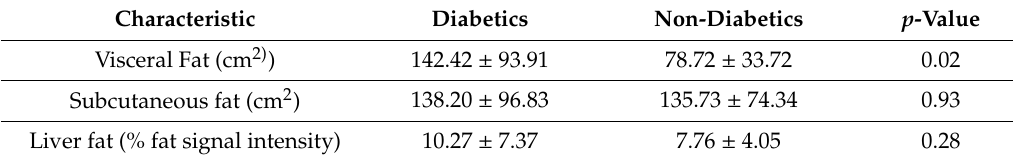
Table 8. Abdominal fat comparison between the diabetics and non-diabetics on MRI.